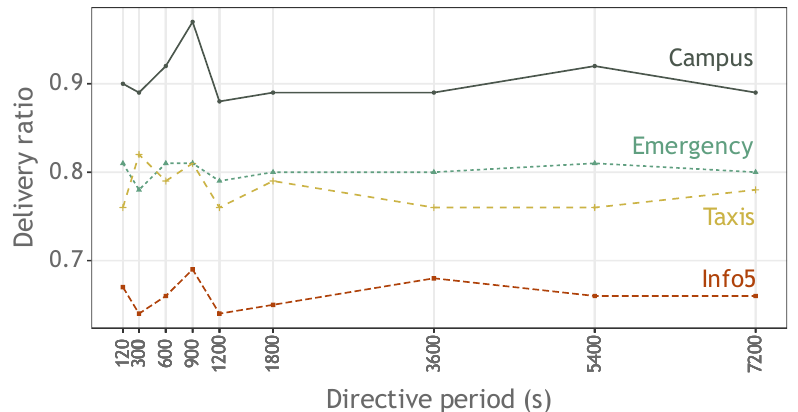
Figure 20. Delivery ratio for different directive generation